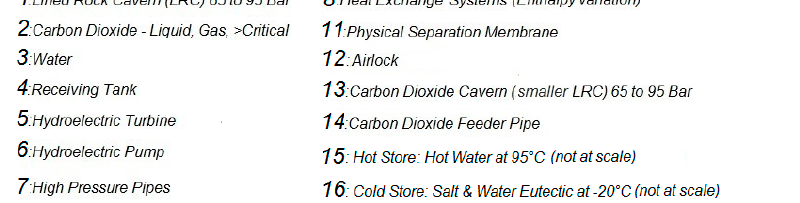
Figure 10. UPHES-PTES for long-duration storage, rigged with two caverns in opposition. A clarification must be made regarding the fact that in the hybrid UPHES-PTES mode, campaigns of electricity charging and campaigns of electricity discharging are usually relatively long in time (5–500 h). Contrary to modes of shorter duration storages described in paragraphs 3.2.1. and 3.2.2 above, each of these charging or discharging campaigns involves several successive expansions plus contractions of CO 2 as well as several successive return trips of hydro-water in and out of the caverns. For calculation of the storage Capex in the hybrid mode, although software simulation and actual experimentation are needed to assess the optimal speed of CO 2 -water interface displacement, a preliminary value of 2.5 h has been selected as the minimal value for the duration of a return trip of hydro-water.